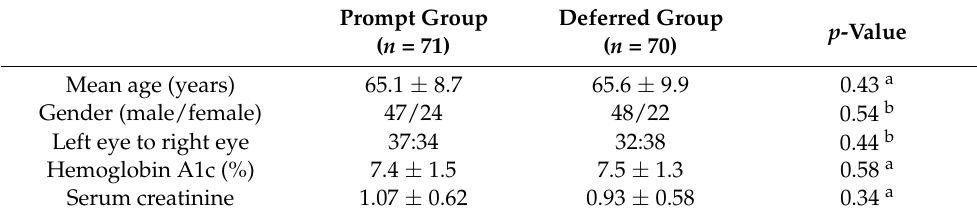
Table 1. Baseline characteristics at the time of